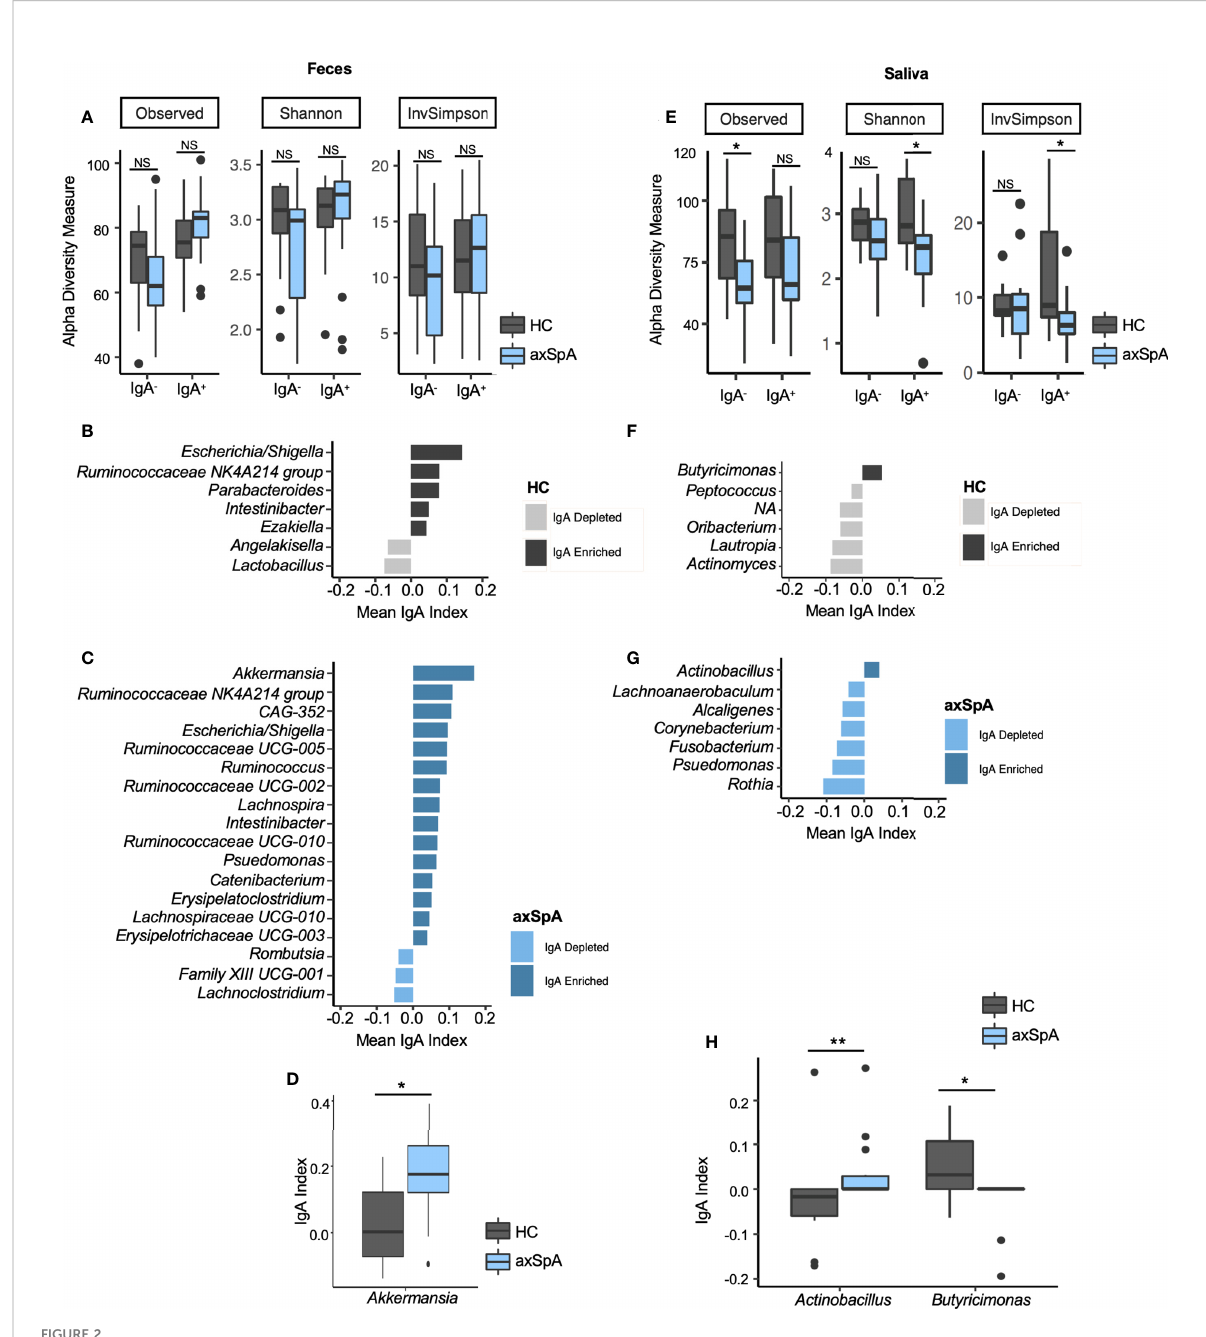
FIGURE 2 IgA-SEQ analyses of fecal and salivary samples in axSpA patients and healthy controls (HC) at the genus level. (A – D) represent fecal samples and (E – H) are salivary samples from axSpA patients (blue) and HC (gray). Alpha diversity plots for IgA - and IgA + fractions with observed, Shannon and Inverse Simpson (InvSimpson) indices for (A) fecal and (E) salivary samples. IgA coating index was calculated for all taxa and signi fi cant taxa are shown for fecal samples for HCs (B) and patients with AxSpA (C) . Similarly, IgA coating index was calculated for all taxa and signi fi cant taxa, and signi fi cant taxa are shown for salivary samples from HCs (F) and axSpA patients (G) . IgA index for differentially abundant microbes in fecal (D) and salivary (H) microbes in axSpA patients and HCs are shown. * P <0.05, ** P <0.01; NS not signi fi